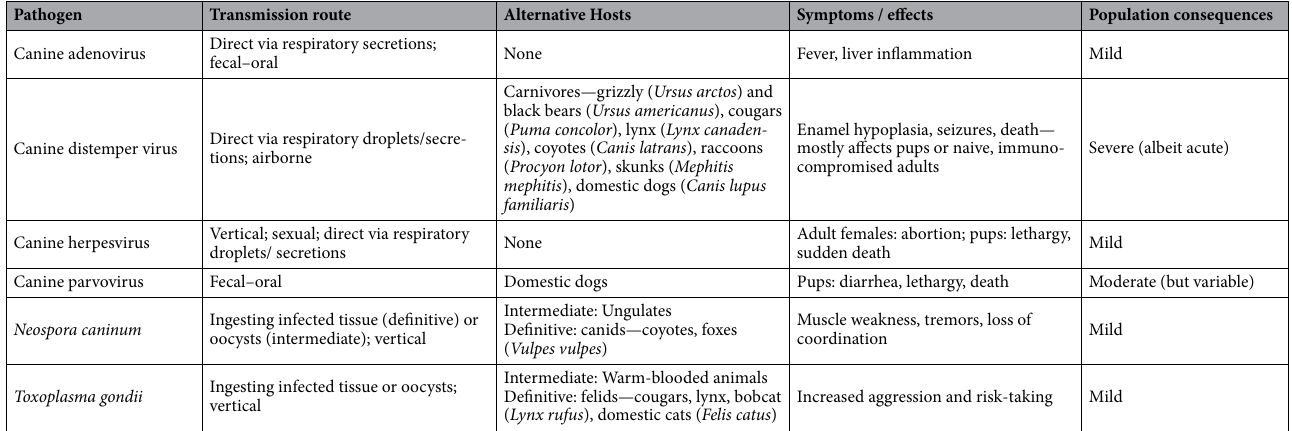
Table 1. A list of wolf pathogens that were examined for populations sampled across North America (Fig. 1) and their characteristics 37 . ‘Alternative hosts’ refers to hosts other than wolves that occur within the study areas that we expect to be important in transmitting pathogens to wolves. ‘Population consequences’ describes the known or expected severity of these pathogen infections on wolf population size or growth rate (minimal, moderate,